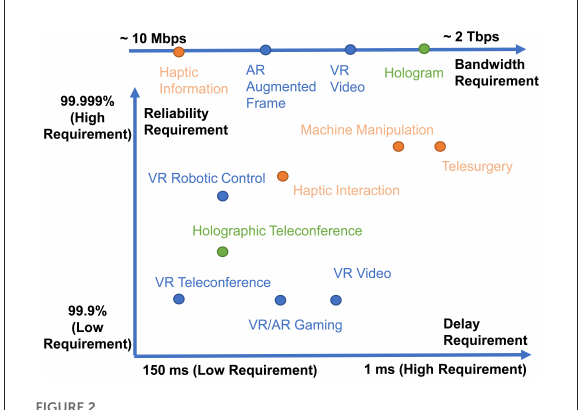
FIGURE2 Requirements of representative immersive communications use cases: an